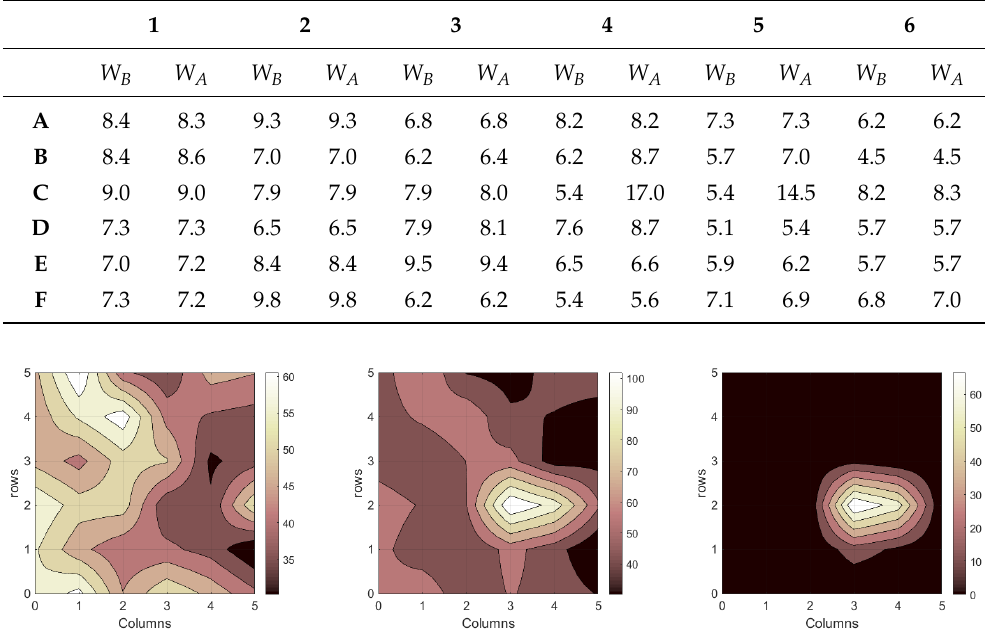
Table 2. Soil moisture values under controlled conditions.